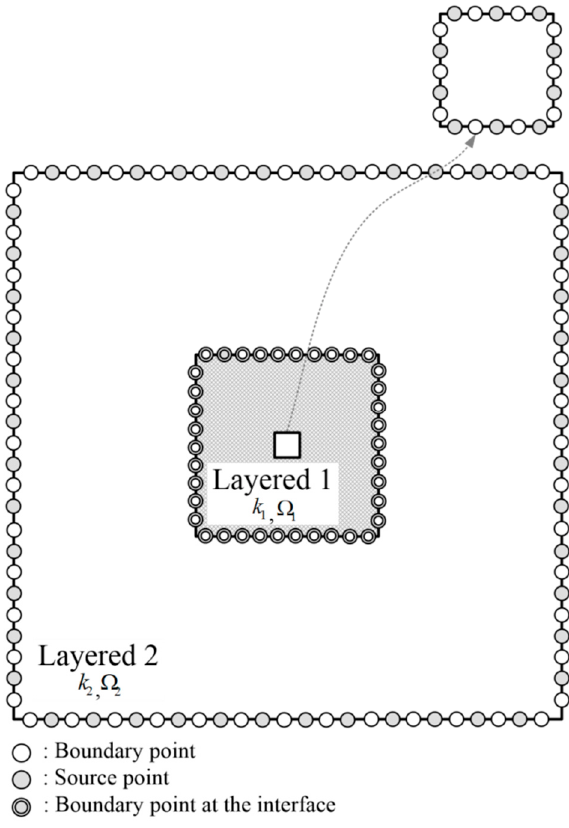
Figure 16. Illustration of the collocation of boundary and source points.